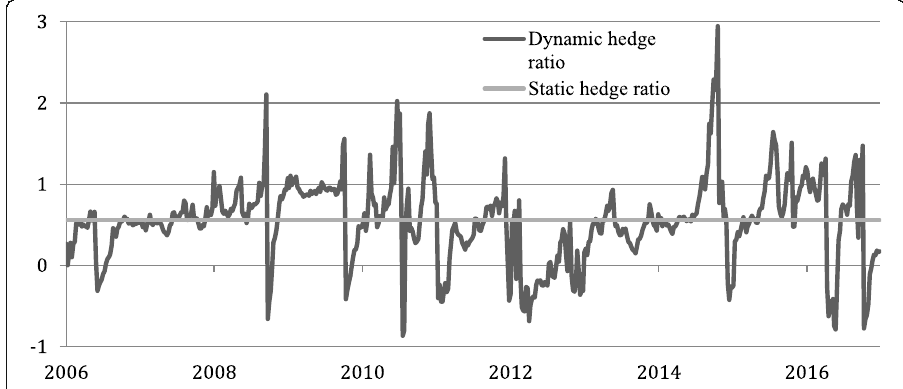
Table 7 Engle-Granger Co-integration test results